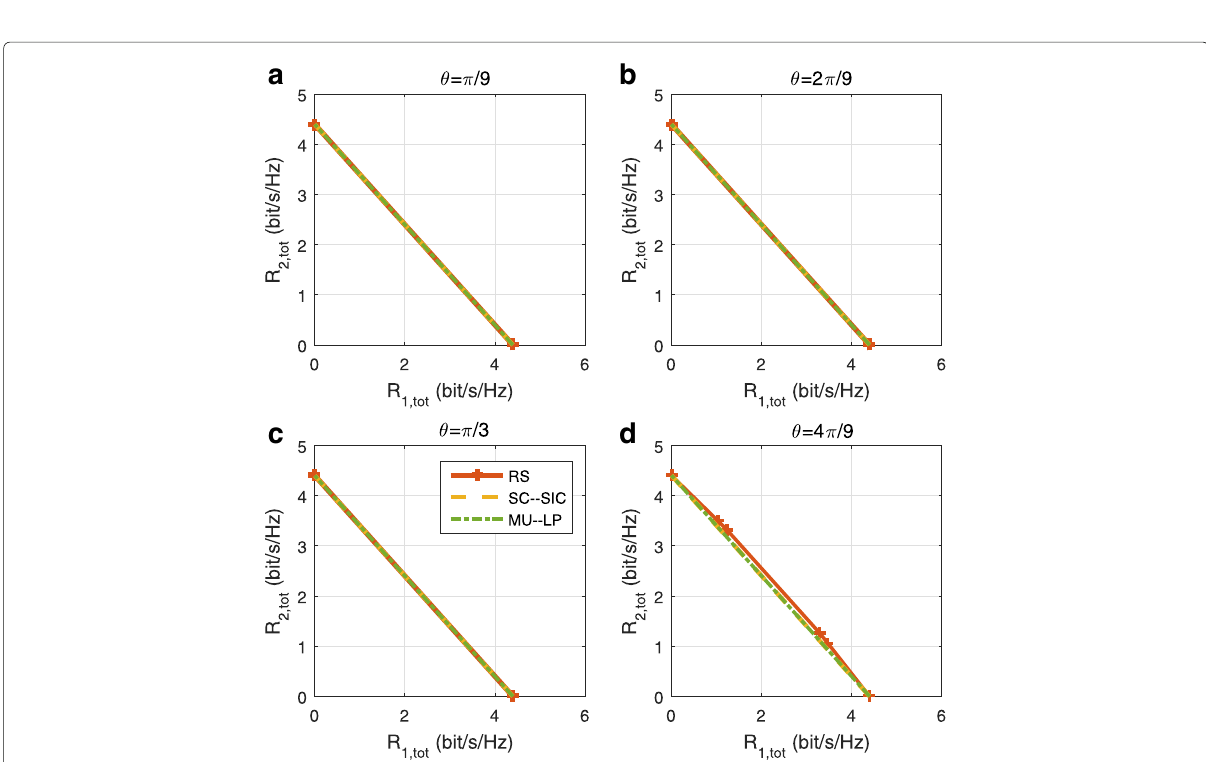
Fig. 28 Average rate region comparison of different strategies in imperfect CSIT, γ = 1, N t = 2, SNR = 10 dB. a θ = π/ 9. b θ = 2 π/ 9. c θ = π/